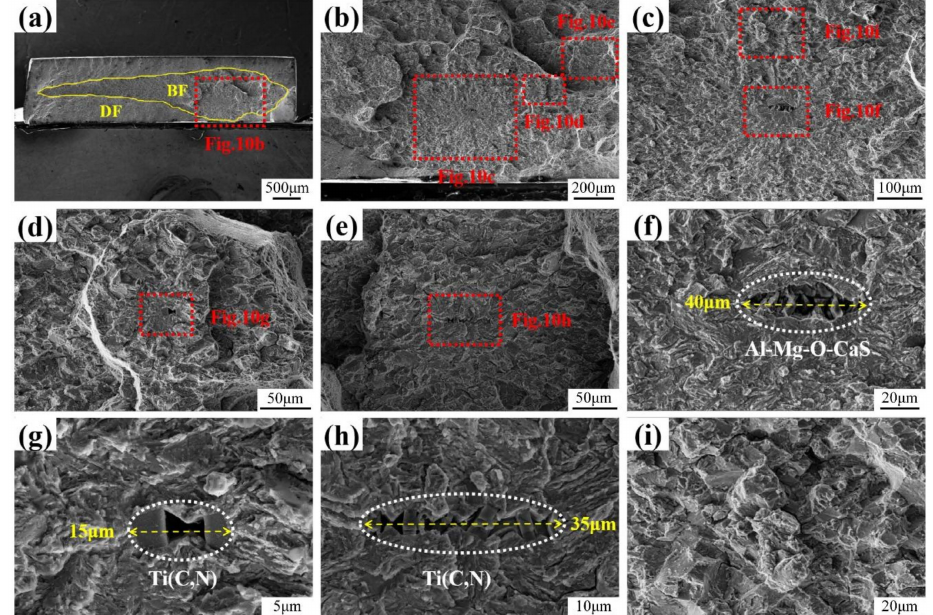
Figure 10. SEM images of fracture surface of specimens with 24 h pre-charging and a strain rate of 1 × 10 − 3 s − 1 . ( a ) Entire image of the fracture surface. Magnified images of the parts surrounded by the red dotted lines in ( b ); in ( c ), ( d ), and ( e ) from ( b ); in ( f ) and ( i ) from ( c ); in ( g ) from ( d ); and, in ( h ) from ( e ). The yellow solid line indicates the boundary between the brittle fractured region (BF) and the ductile fractured region (DF). The white dotted line in ( f ), ( g ), and ( h ) indicates the inclusions that induced